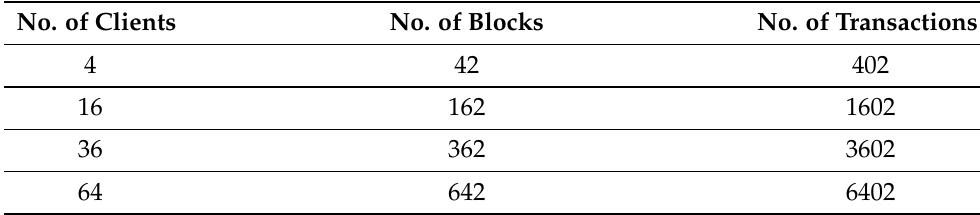
Table 3. Register meter: Single host.